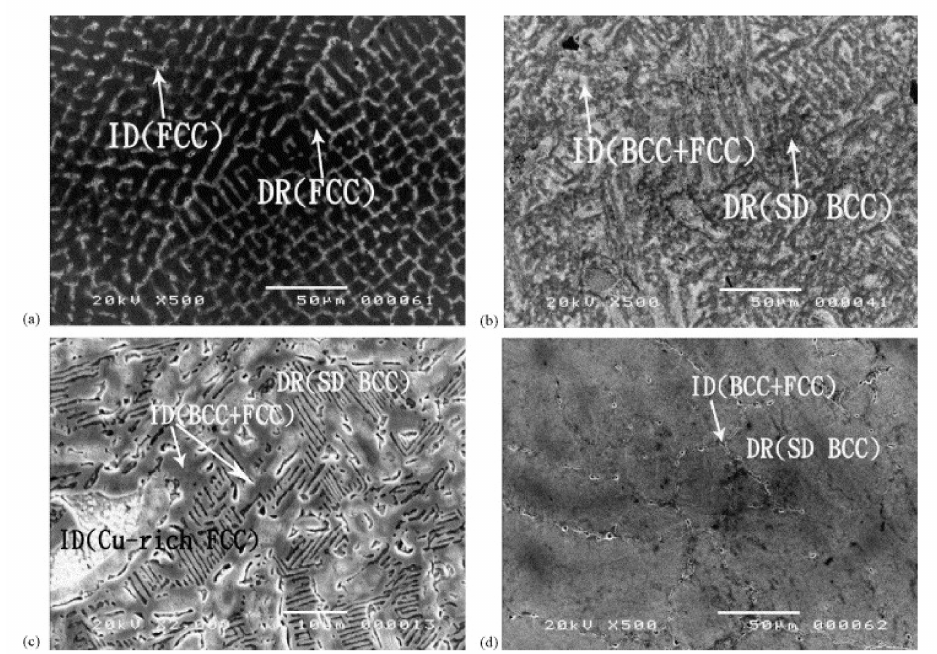
Figure 9. SEM micrographs of AlxCoCrCuFeNi HEAs with x: ( a ) 0.5, ( b ) 1.0, ( c ) 1.0, and ( d ) 2.0